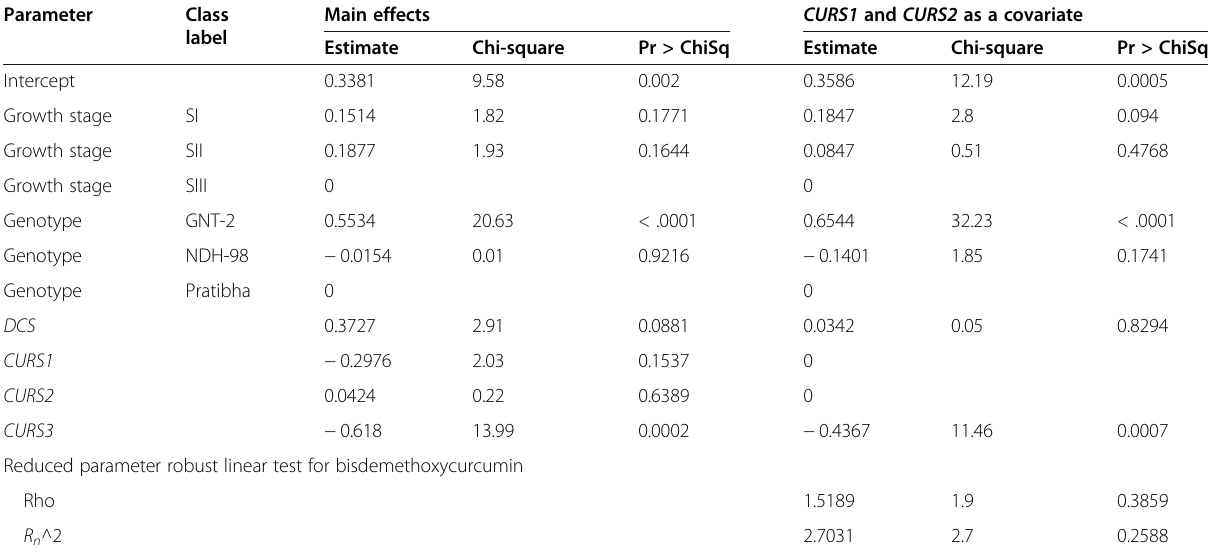
Table 5 Association-based test of DCS and multiple curcumin synthases with bisdemethoxycurcumin